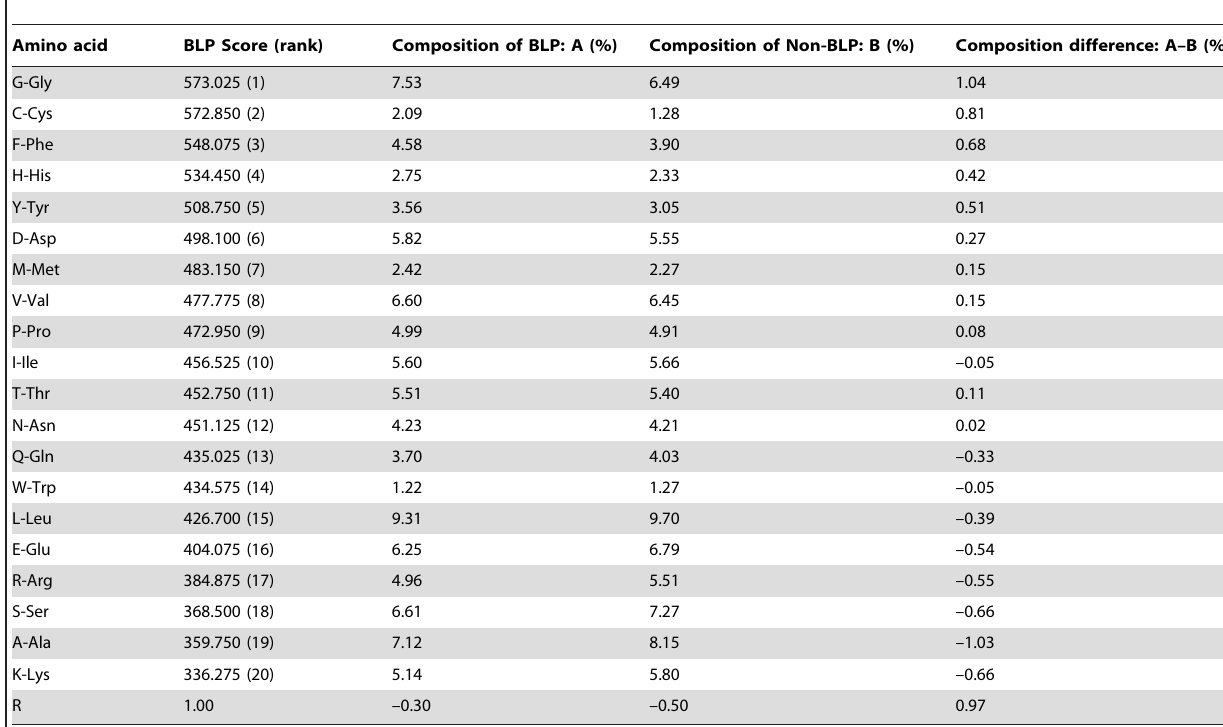
Table 1. The propensity scores of amino acids to be a bioluminescent protein (BLP) and amino acid composition (%) using BLP-